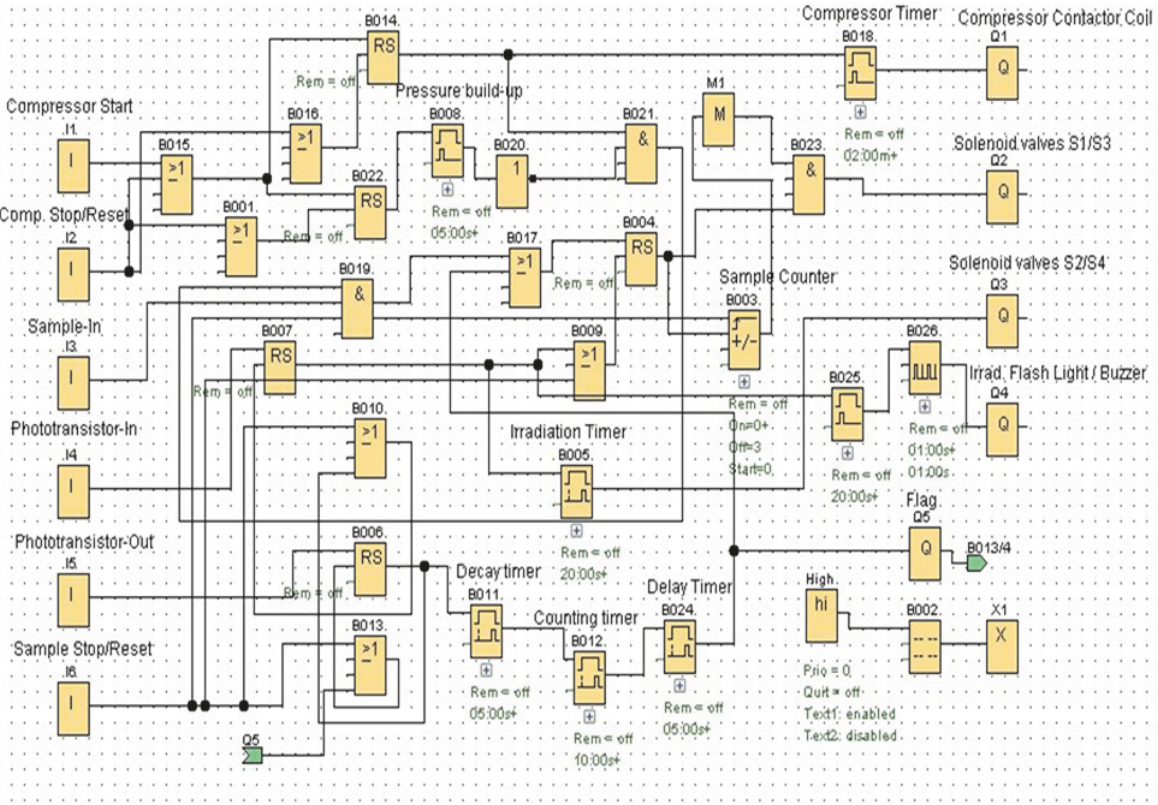
Figure 8: Designed cyclic mode activation